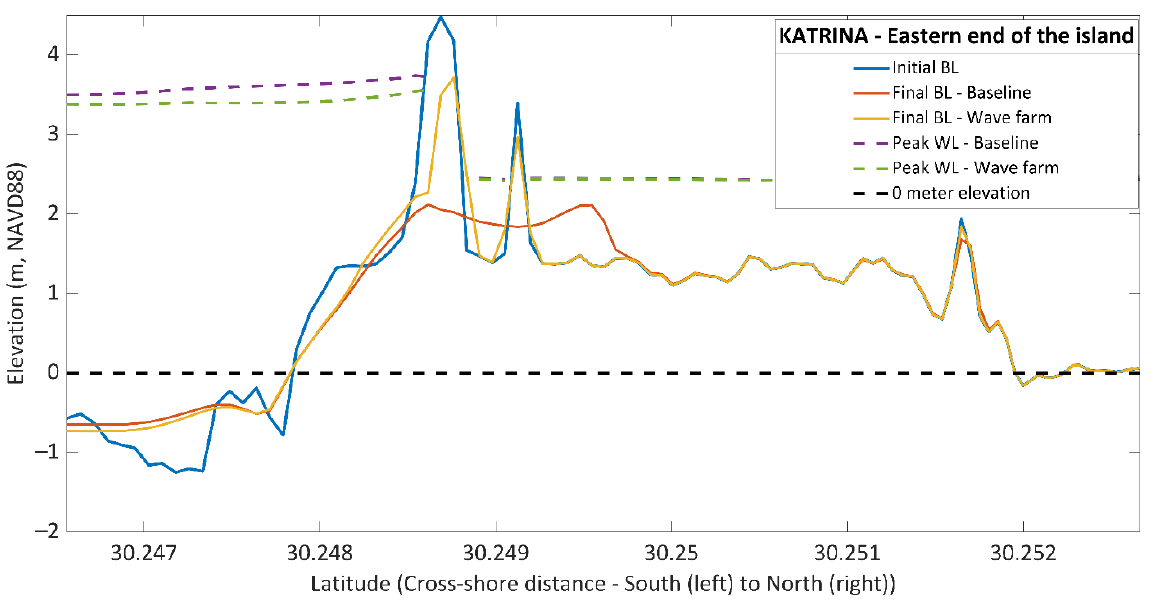
Figure 13. Bed levels (BL) and water levels for Dauphin Island, AL under Hurricane Katrina conditions for baseline and wave farm scenarios at the location where the maximum dune height difference between the two scenarios occurs.